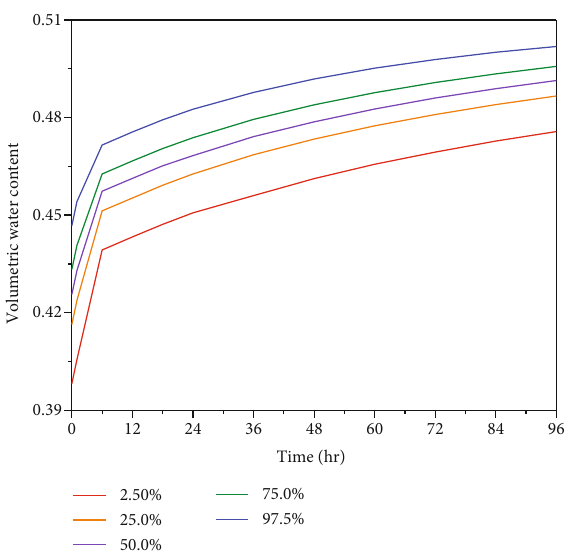
Figure 10: Volumetric water content at 1m depth of the observation pro fi le with di ff erent percentiles of the SWRC.